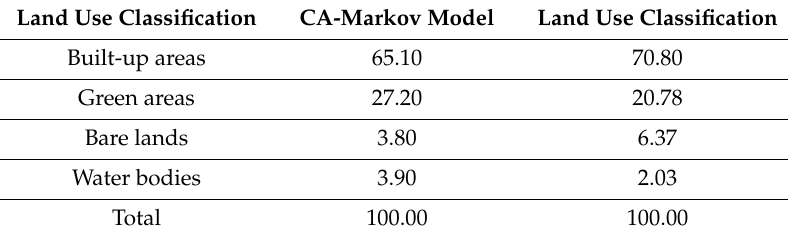
Table 6. Prediction results of land-use change in Nakhon Ratchasima in 2016 using CA-Markov Model and satellite image